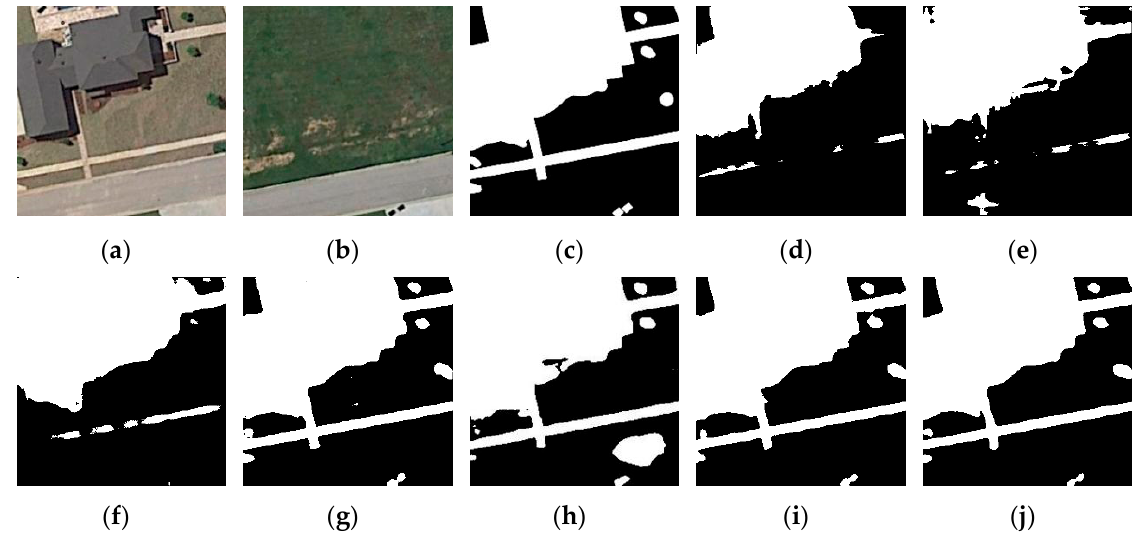
Figure 6. Visual comparison of change detection results in area 1: ( a ) T1 image, ( b ) T2 image, ( c ) ground truth, ( d ) FC-EF, ( e ) FC-Siam-conc, ( f ) FC-Siam-diff, ( g ) UNet++_MSOF, ( h ) IFN, ( i ) SNUNet-CD/32, ( j ) proposed method. The changed areas are marked by white, and the unchanged areas are marked by black.